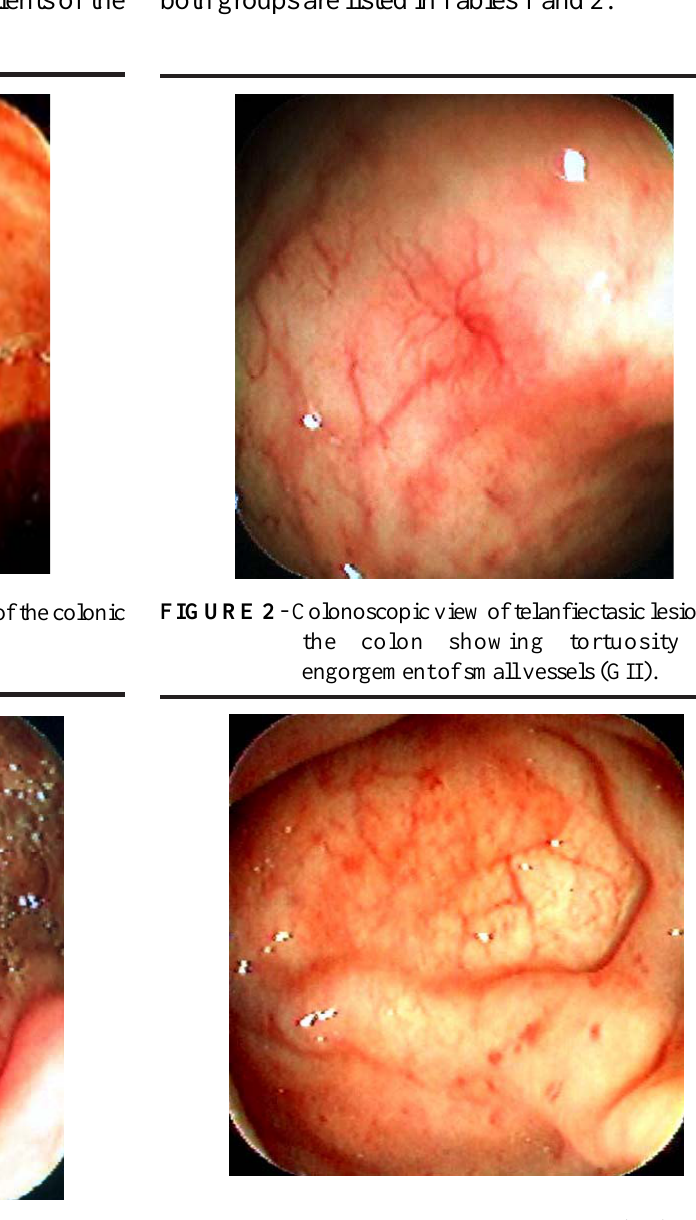
FIGURE 3 - Colonoscopic view of angiodysplastic-like lesions in the caecum (GII). TABLE 1 - Frequencies of vascular abnormalities: colonoscopic findings in Group I Colonic vascular abnormality